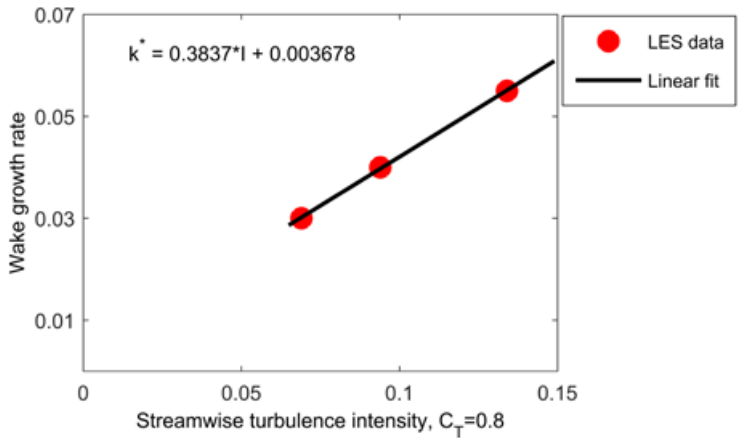
Figure 1. Wake growth rate for the V-80 turbine in boundary layer flow with different streamwise turbulence intensities at hub height.